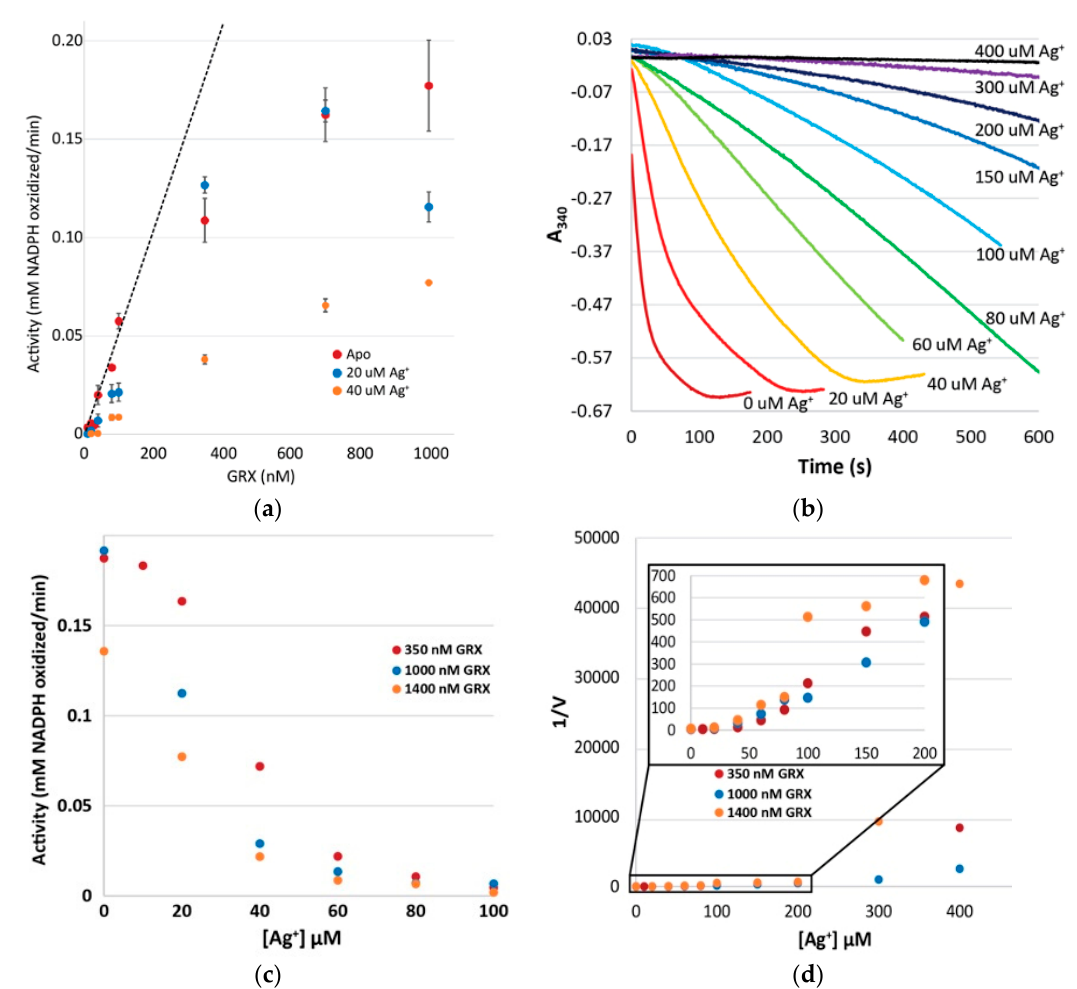
Figure 11. GRX activity under varying enzyme and silver concentrations. ( a ) A range of GRX concentrations were measured in triplicate as apo protein and inhibited with two constant silver concentrations. The dashed line indicates theoretical apo rate. Calculated activity as NADPH consumed over time from the HEDS assay. ( b ) Raw absorbance data from silver inhibition with 1400 nM GRX. Plotting activity from these data ( c ) produces inhibition plots that show a sigmoidal trend as a function of increasing silver. ( d ) Dixon plots of the reciprocal activity give rise to parabolic trends that support dimer inactivation.